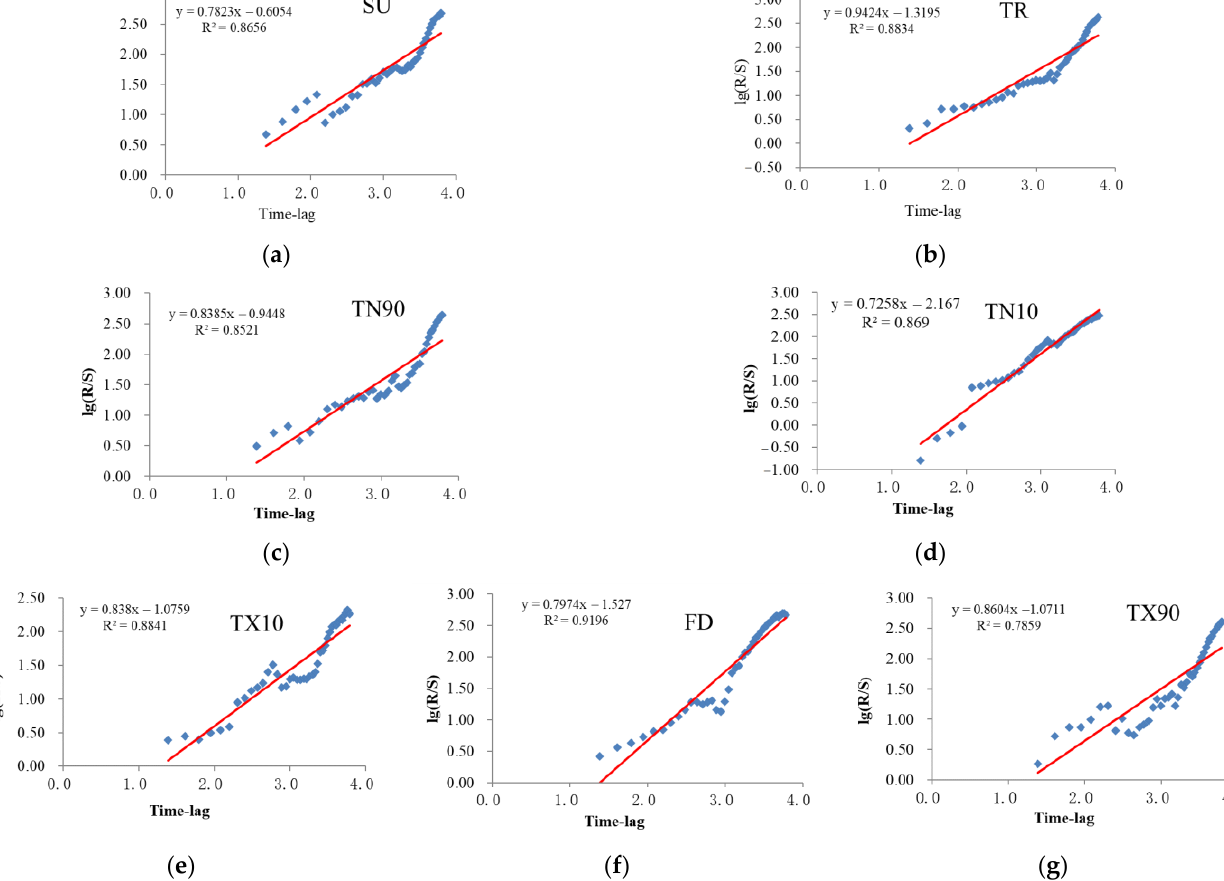
Figure 13. The extreme temperature indices of R/S analysis results in Yangtze River Basin from 1970 to 2014. ( a ) is SU, ( b ) is TR, ( c ) is TN90, ( d ) is TN10, ( e ) is TX10, ( f ) is FD and ( g ) is TX90.